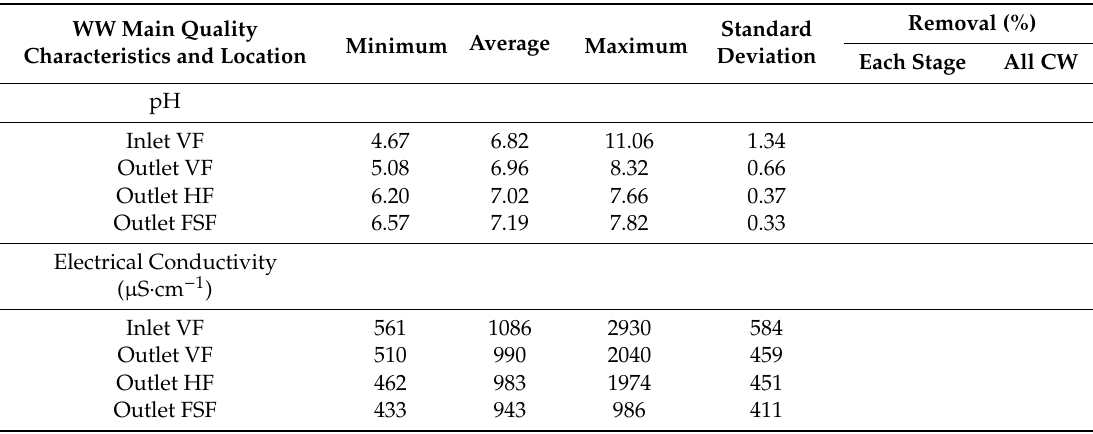
Table 1. Wastewater (WW) quality at the inlet and outlet of each constructed wetland (CW) stage